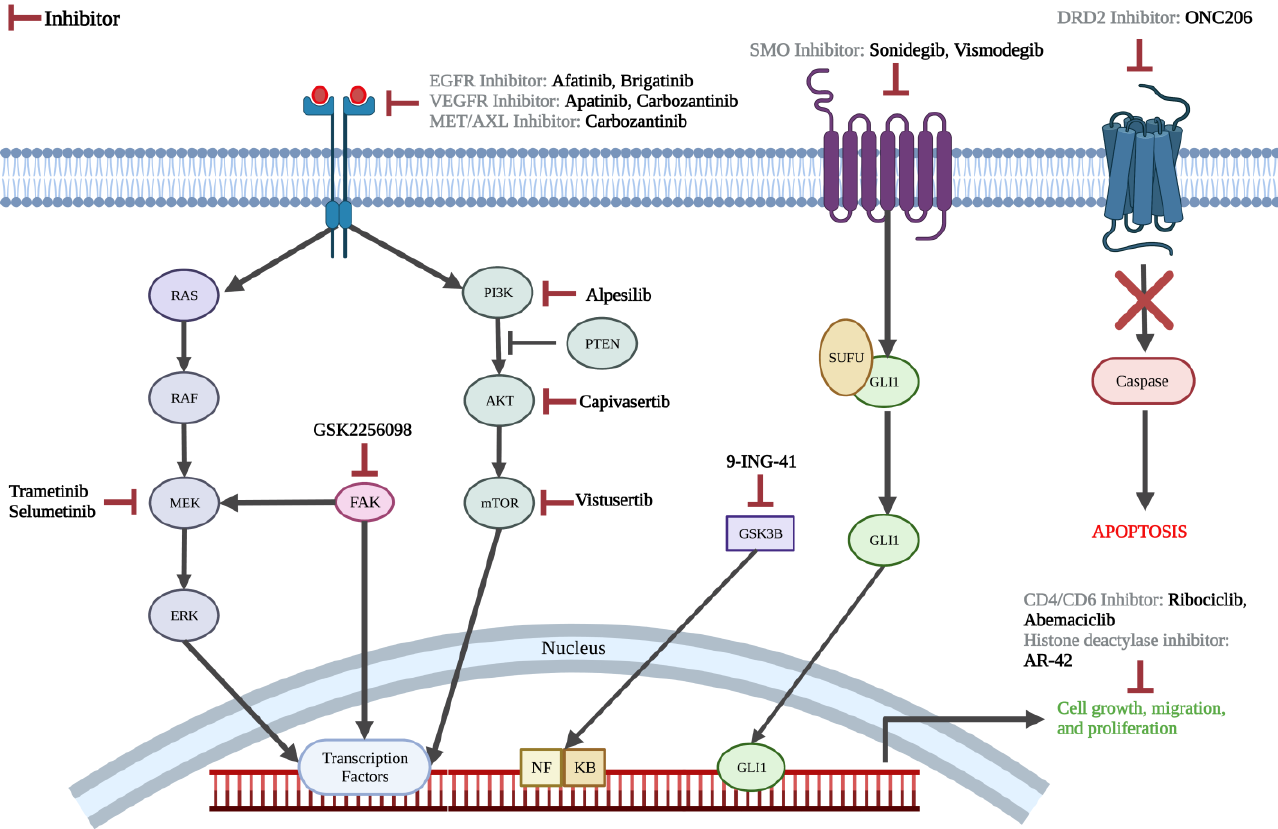
Figure 2. Molecular pathway highlighting the action of chemotherapy agents being studied in ongoing clinical trials. Made on biorender.com.